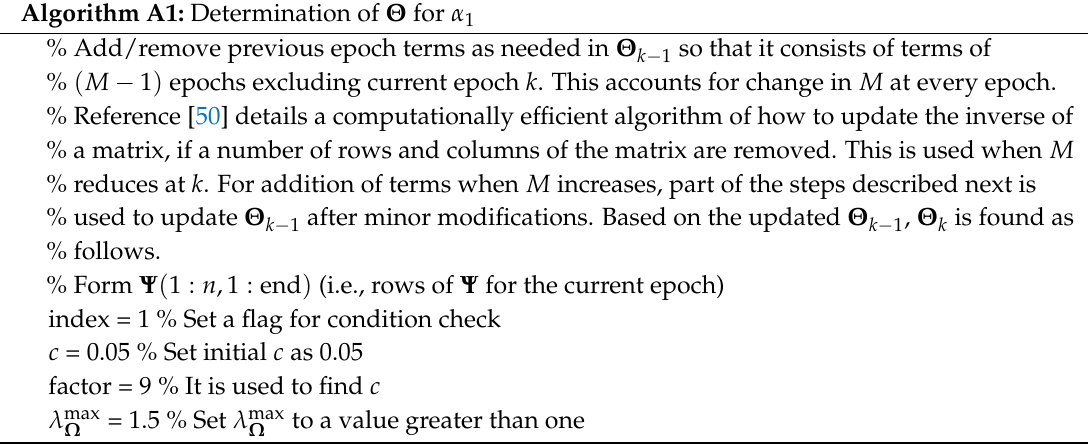
Algorithm A1: Determination of Θ for α